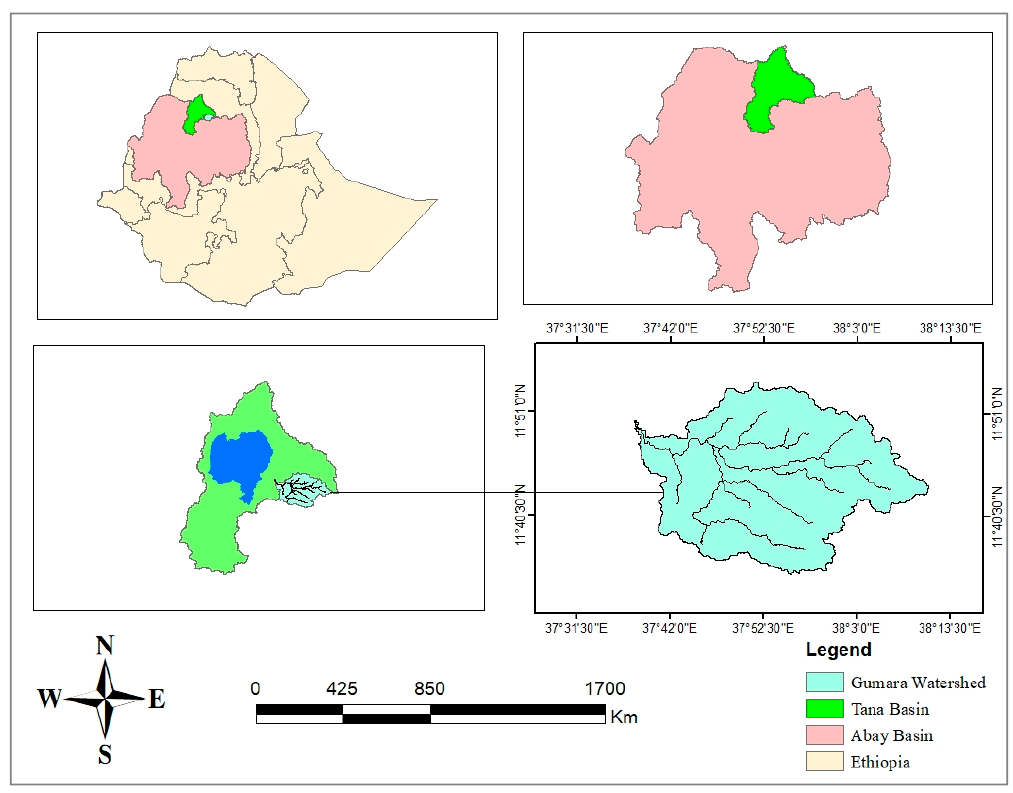
Figure 1. Location map of study area.